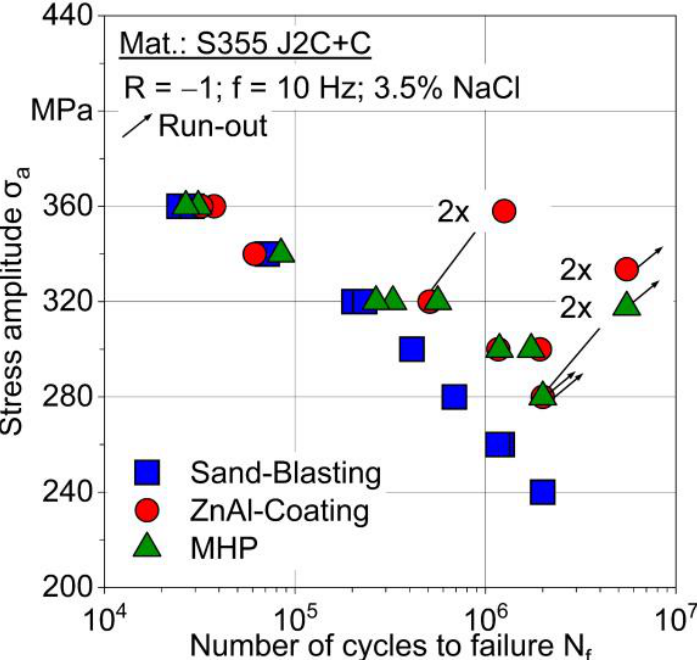
Figure 11. S-N diagram for specimen conditions: Sand-Blasting (I), ZnAl-Coating (II), and machine hammer-peened (III).